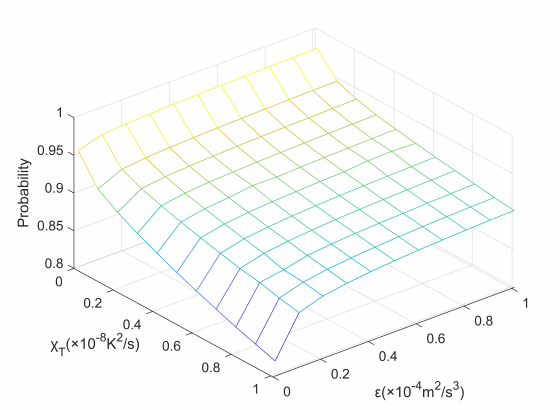
Figure 3. Received probability of the OAM signal modes of DARR beam versus dissipation rates of the mean-squared temperature χ T and the dissipation rates of kinetic energy per unit mass of fluid ε .